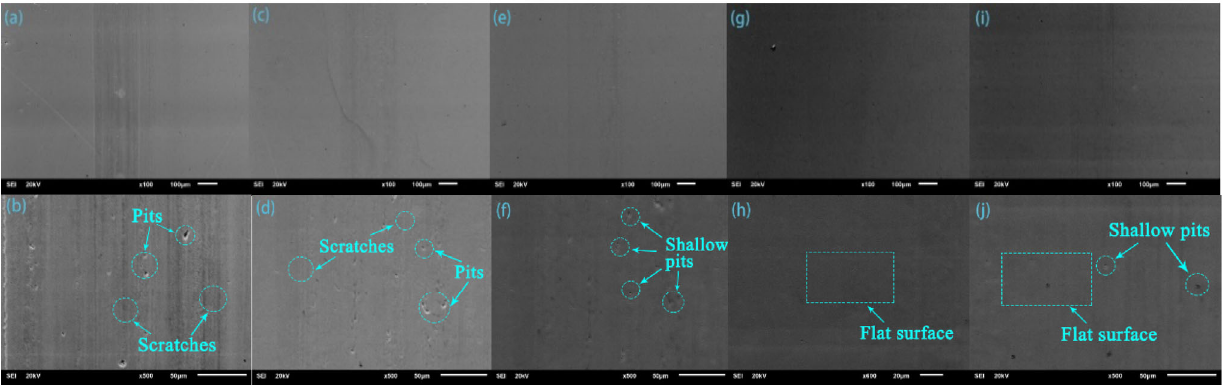
Fig. 8 SEM images of steel plate surfaces lubricated with different greases: (a, b) LCG, (c, d) 2% IL-PANI, (e, f) 3% WS 2 , (g, h) 2% PW10, and (i, j) 2% PW30 (voltage: 0 V; load: 150 N; frequency: 5 Hz; stroke: 5 mm).